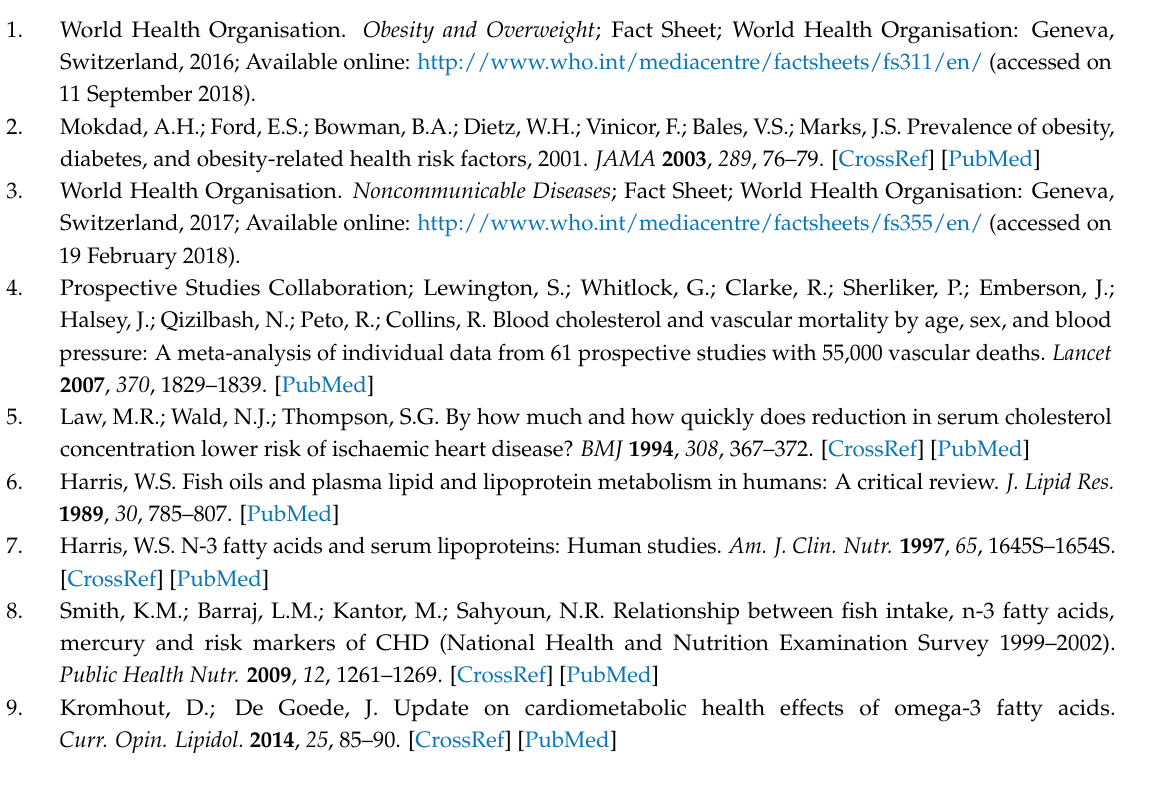
Table S1: Saturated, monounsaturated and n-6 polyunsaturated fatty acids, and ratio of n-3/n-6 polyunsaturated fatty acids in serum and